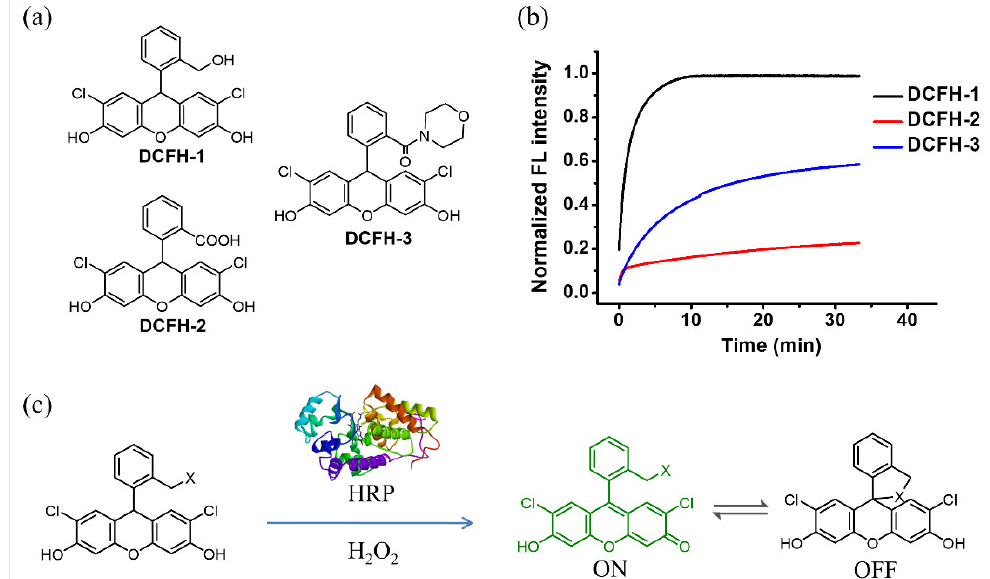
Figure 1. ( a ) The structures of the synthetic DCFHs. ( b ) Reaction kinetic curves by monitoring the fluorescence of the reaction solution, the maximum intensity was normalized to 1 for easier comparison. ( c ) Schematic figure shows the HRP catalyzed reaction on DCFHs.